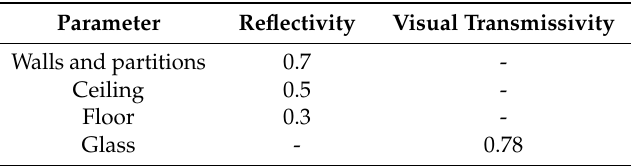
Table 4. Simulation parameters using Daysim.